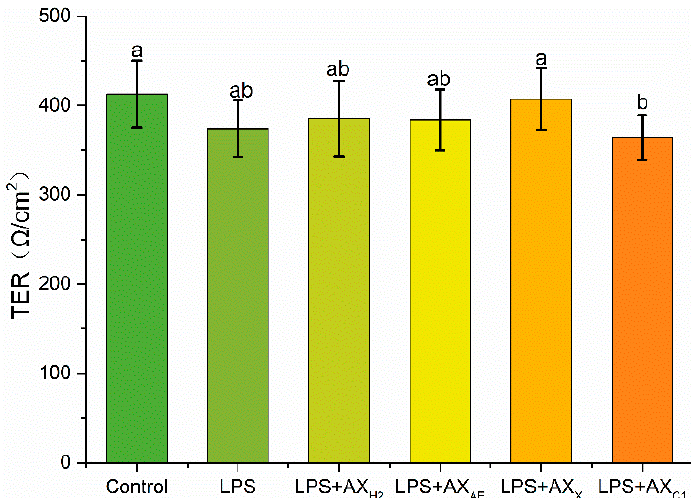
Figure 4. Transepithelial electrical resistance after treated with LPS. Control, without LPS or arabi- noxylan hydrolysates; AX H2 , triticale bran arabinoxylan was treated with 0.15 M HCL; AX AE , triticale bran arabinoxylan was treated with α − L − arabinofuranosidase; AX C1 , triticale bran arabinoxylan was treated with 0.1 M citric acid; AX X , triticale bran arabinoxylan was treated with endo − 1,4 − β − xy- lanase. Values represented in this figure consist of mean ± standard deviation ( n = 3). Values with different superscript letter are significantly different ( p < 0.05).